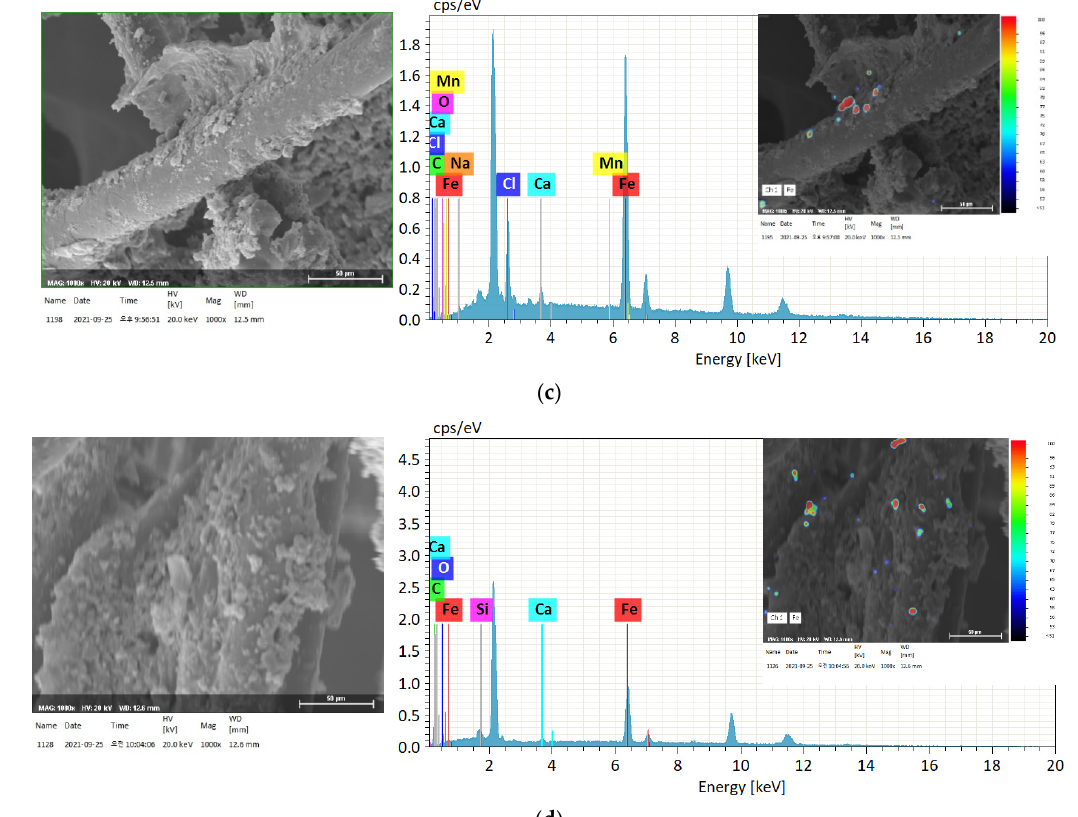
Figure 8. Scanning electron microscope photomicrographs and energy-dispersive X-ray spectroscopy analysis of typical Fe particles: ( a ) sampling area A; ( b ) sampling area B; ( c ) sampling area C; ( d ) sampling area D. Table 10. Energy-dispersive X-ray spectroscopy analysis of equivalent circle diameters ( µ m)